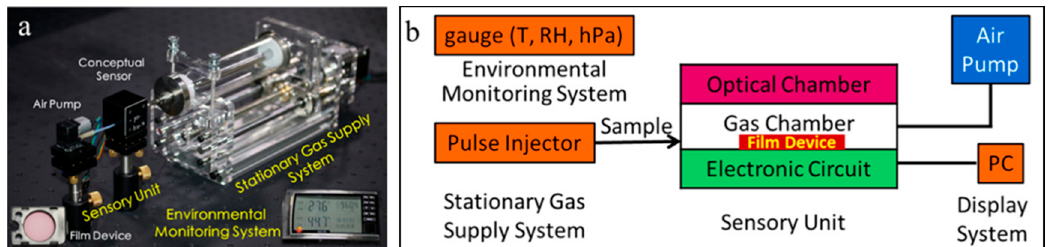
Figure 2. ( a ) The picture of the gaseous analyte detection platform based on the film device; ( b ) Schematic description of the home-made sensing platform [24].